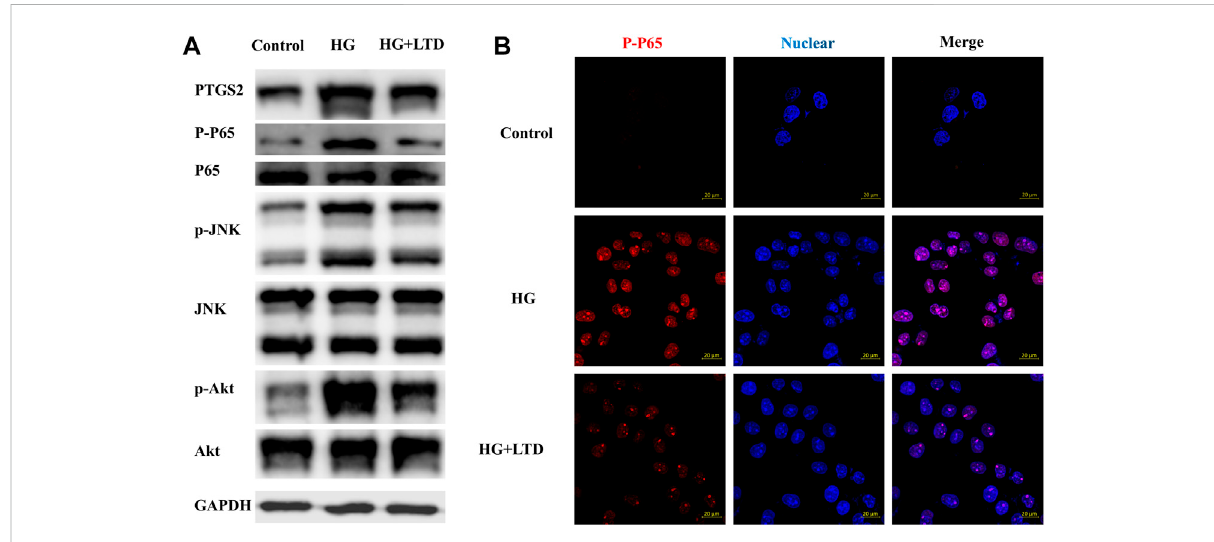
FIGURE 8 LTDsigni fi cantlyreducedPTGS2,NF- κ B,JNK,andAKTexpressionsinHK-2CellsunderHGambience. (A) RelativeproteinexpressionofPTGS2, NF- κ B, JNK, and AKT in the HK-2 Cells of the control, HG, and HG + LTD groups by western blot analysis. Representative bands show the relative expression of PTGS2, NF- κ B, JNK, and AKT. (B) The fl uorescence intensity (red) indicated the expression level of P-P65 in HK-2 of the control, HG, and HG + LTD groups by immuno fl uorescence. Red and blue fl uorescence represent P-P65 and the cell nucleus,